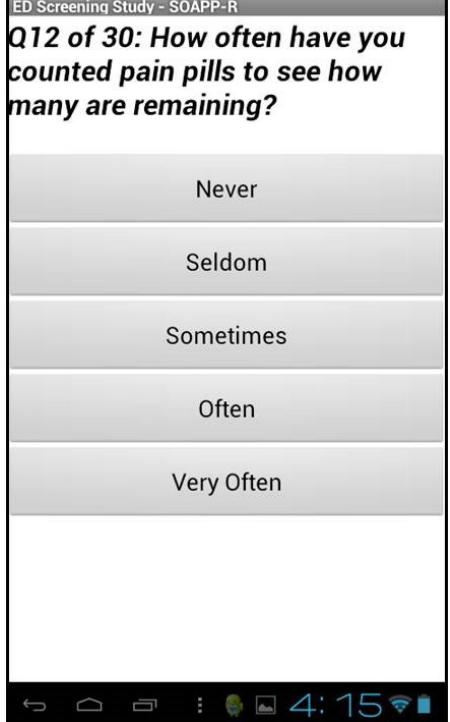
Figure. Sample screenshot of the electronic screening tool.